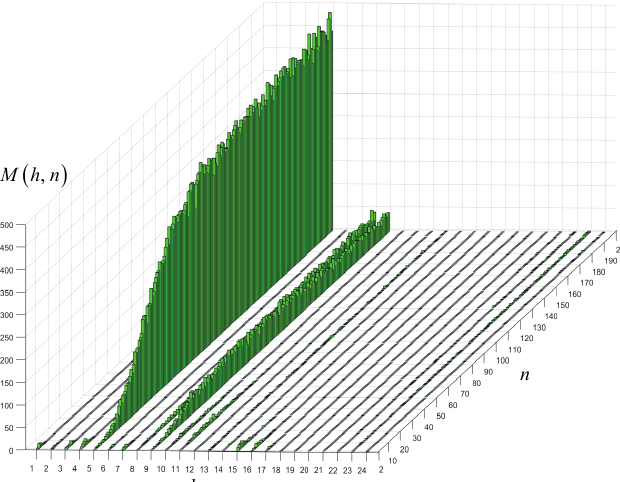
Fig. 3. The number of times when the heuristic “wins” solely versus the number of jobs to be scheduled (per 1000 instances).